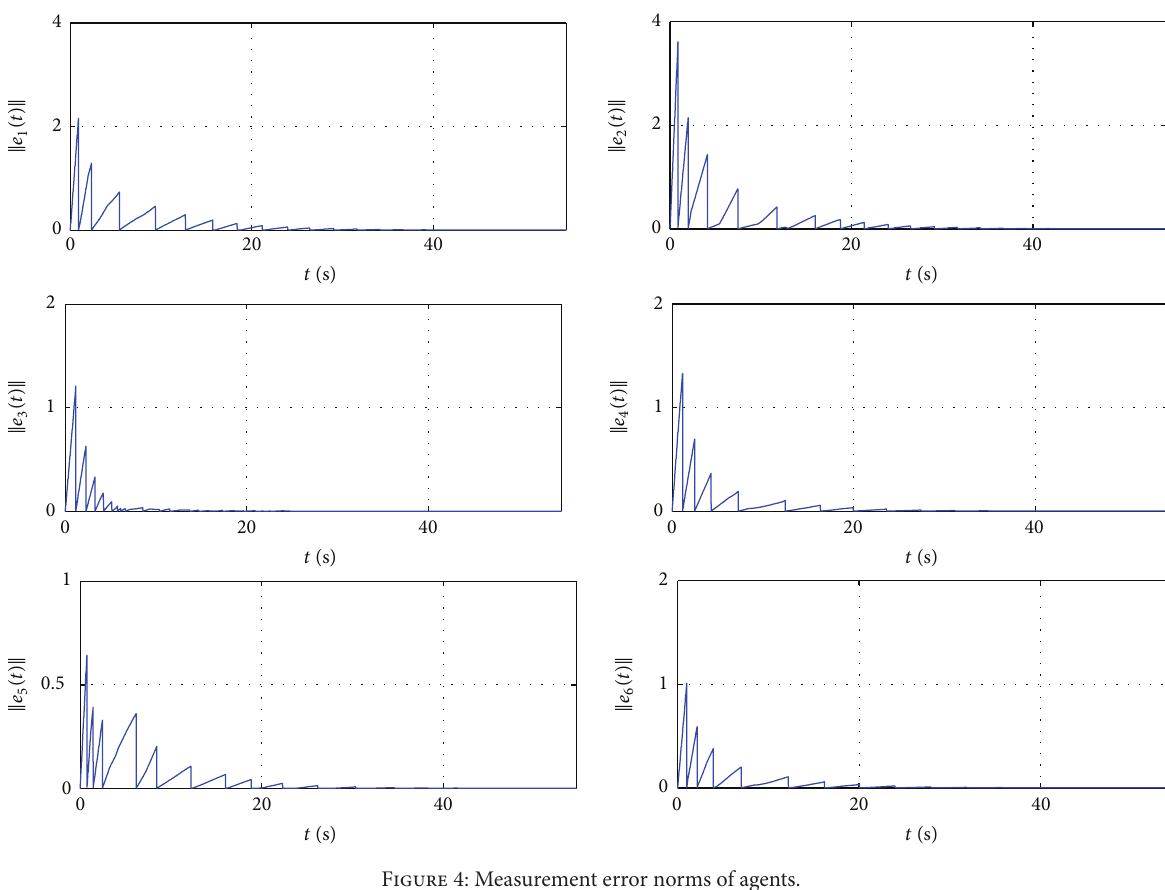
Figure 4: Measurement error norms of